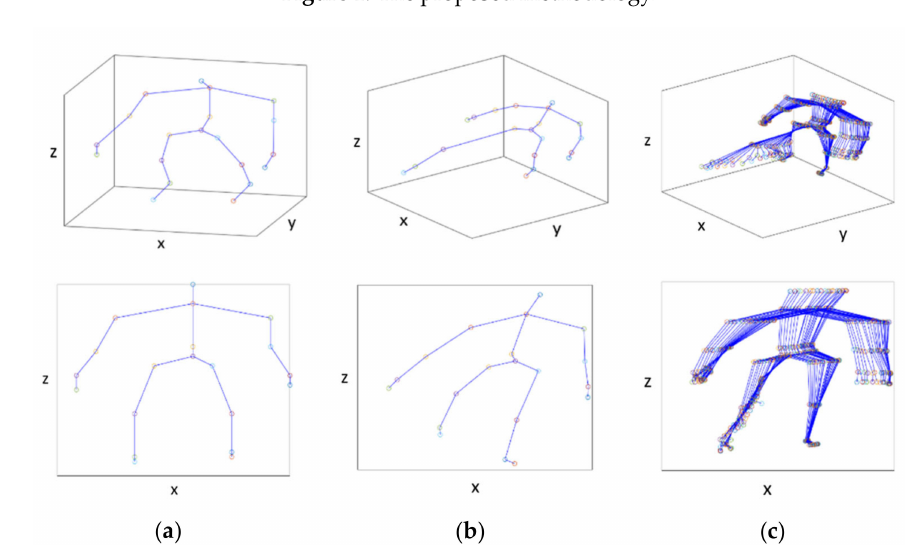
Figure 1. The proposed methodology.